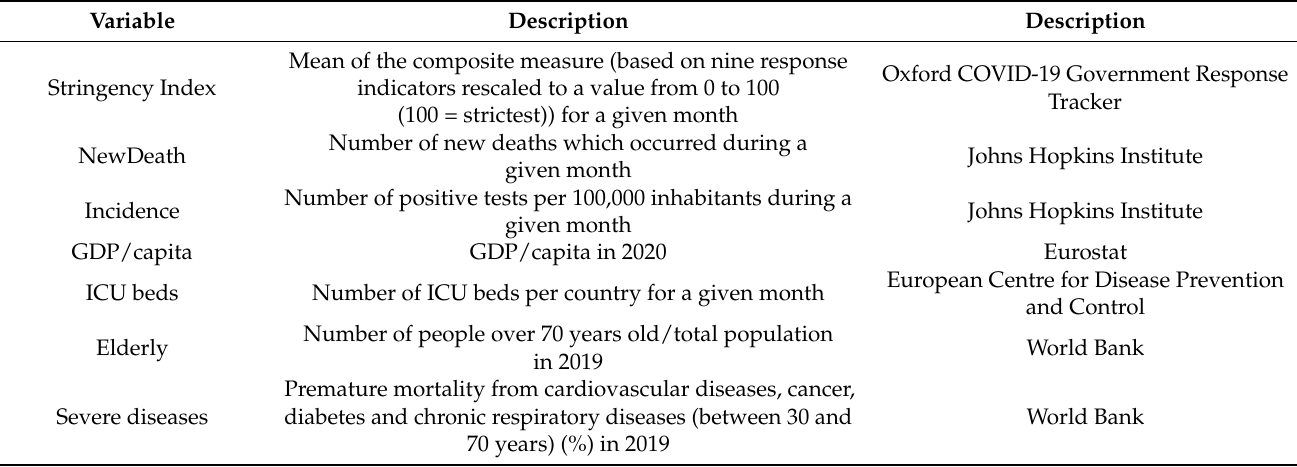
Table 1. Description of the